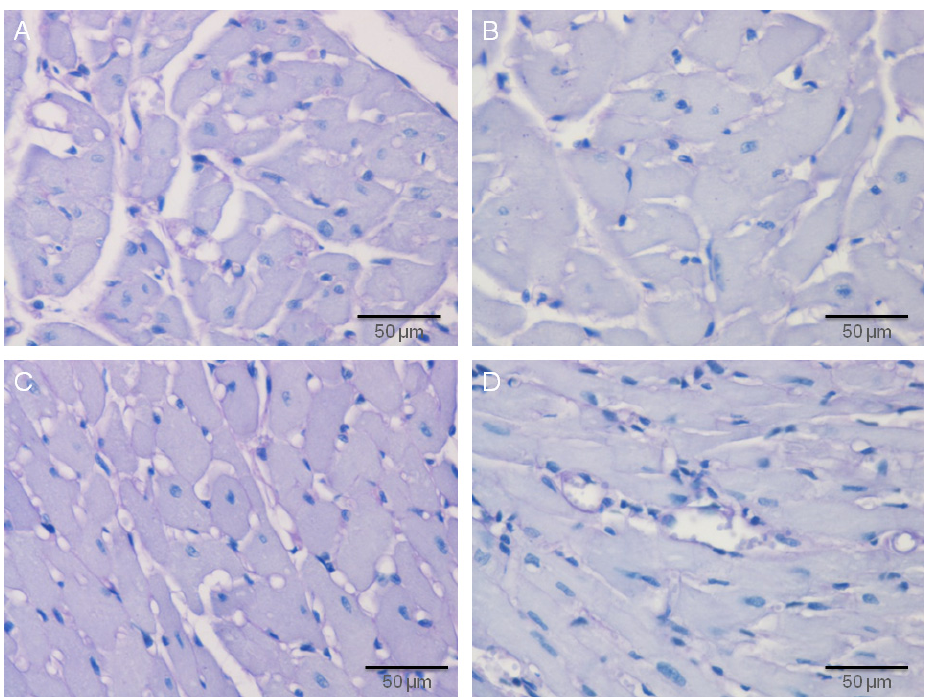
Figure 5. Protective effects of resveratrol treatment in the heart tissue of the essential and malig- nant hypertensive rats, Hematoxylin and Eosin (H&E) method, 200× magnified images. ( A ) Diffuse vacuolation of the myocytes in the heart tissue of SHR, ( B ), vacuolar degeneration of the myocytes in the heart tissue of MHR, ( C ) mild hypertrophy of the myocytes in the heart tissue of SHR + R, and ( D ) macronodular vacuolation of the myocytes in the heart tissue of MHR + R. In edematous myocytes, the cytoplasm is filled with large, clearly visible